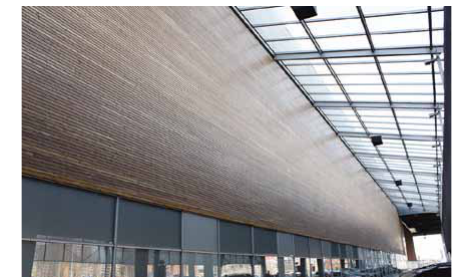
Fig. 1. Observation and information pavilion, Norway, archit. office “Snohetta”, 2011